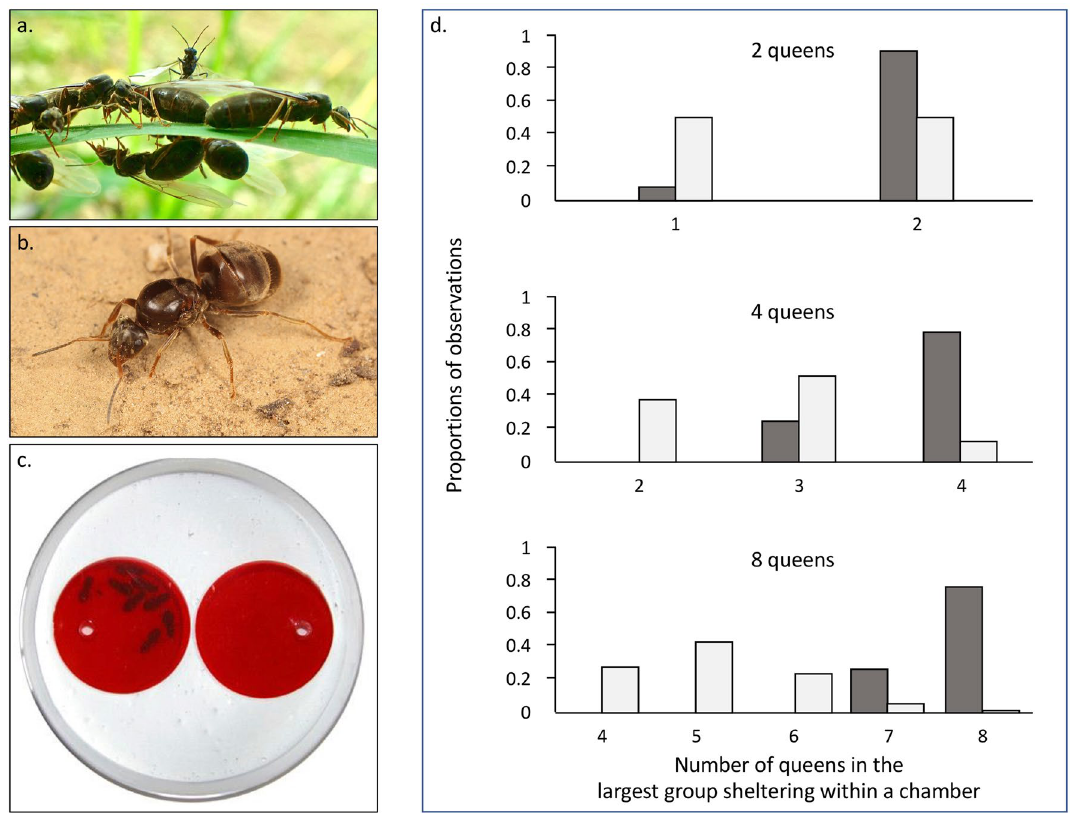
Figure 1. Grouping patterns of L. niger founding queens. ( a ) Virgin winged L. niger queens embarking on their mating flight from their nest of origin. In the centre of the image is a male standing on the wings of a queen. Picture: Q. Willot. ( b ) After mating, queens land and then lose or tear off their wings. They subsequently search for small burrows in the ground in which they found new colonies, either alone or with other queens. Picture: H. Darras. ( c ) Queen grouping during one of the experimental trials: 8 newly mated queens have clustered in a single nesting chamber. ( d ) Proportion of observations as a function of the number of queens in the largest group sheltering within a chamber (dark grey), and theoretical distribution (light grey) based on the assumption of random assortment (see “Methods”). Experimental trials were performed with N = 2 queens ( n = 34), 4 queens ( n = 23), and 8 queens ( n = 25). For example, three situations were possible in trials with 4 queens: 2 queens in each chamber (2); 3 queens in one chamber and 1 queen in the other chamber (3); and all 4 queens in a single chamber (4). The graphs only show results for experimental trials in which all the queens were sheltered (i.e., none remained in the